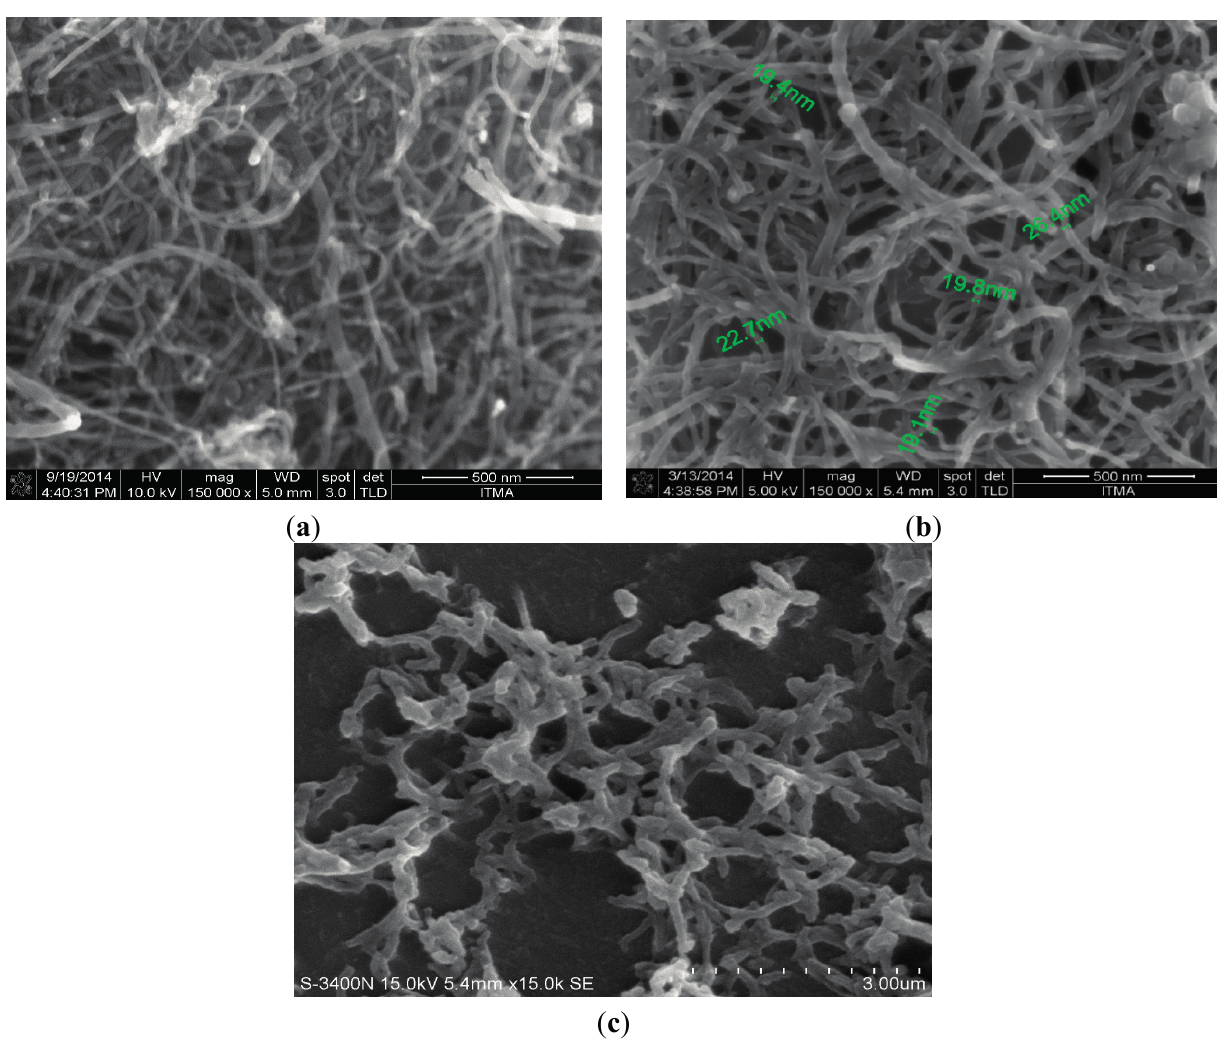
Figure 7. ( a ) SEM micrograph of MWNT; ( b ) SEM micrograph of functionalized CNT; ( c ) SEM of